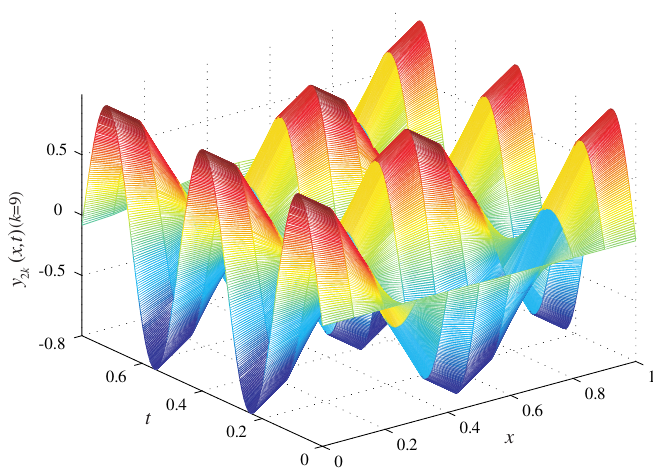
Figure 3. The ninth iterative output y 1 k ( k = 9 ) .